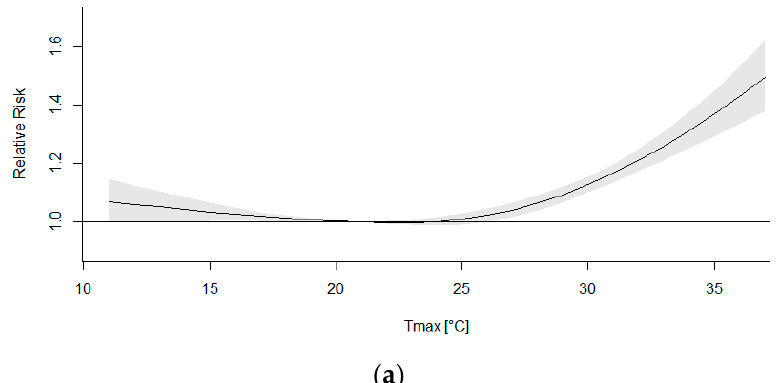
Figure 8. Relation between daily maximum temperature and relative mortality risk (all non-accidental causes) in warm months (June–September) for towns with population of below 10 thousand during 2001–2016: ( a ) Wielkopolska; ( b ) Małopolska.